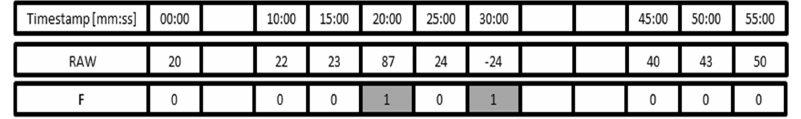
Figure 2. Raw data with faulty and missing data.